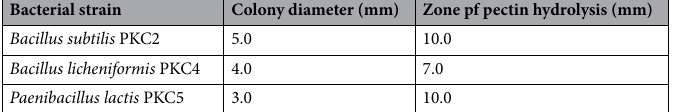
Table 3. Colony diameter and zone of hydrolysis.